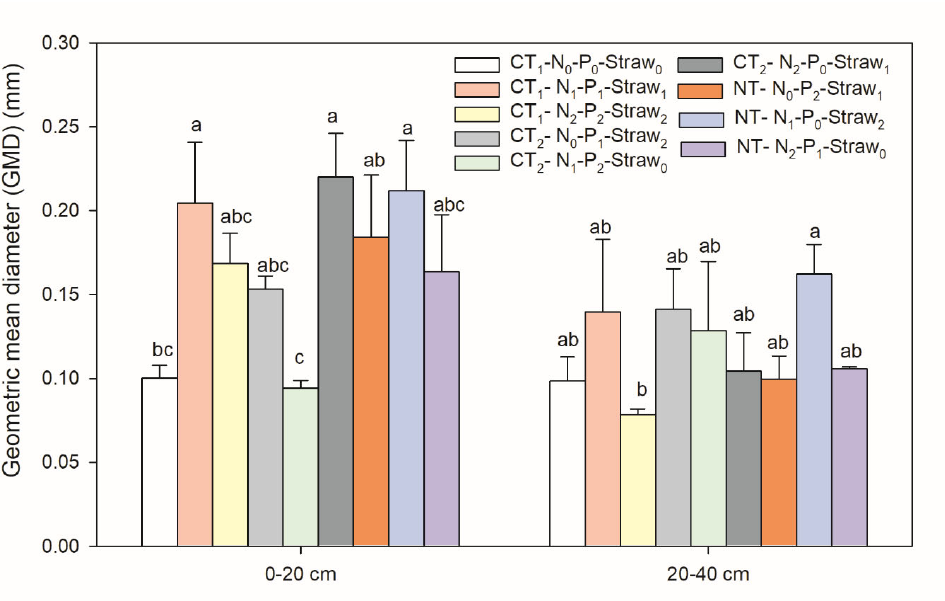
Figure 5. The geometric mean diameter (GWD) of different tillage management and fertilization at 0–20 and 20–40 cm. Bars followed by similar letters between treatments within a soil layer are not significantly di ff erent according to Tukey’s HSD test. CT 1 turned straw into the soil and CT 2 covered straw on the